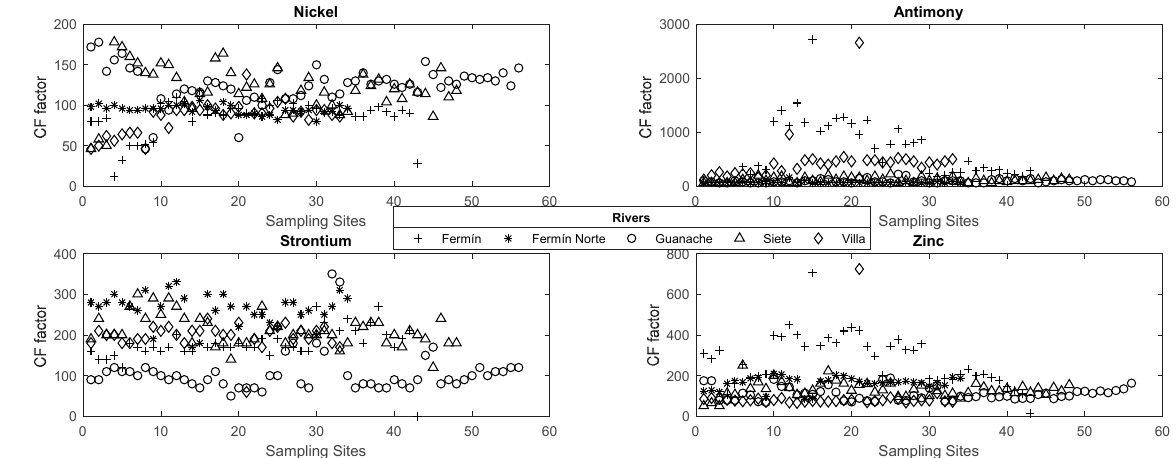
Figure 8. Downstream longitudinal sequence plots of contamination factor for Ni, Sb, Sr and Zn.